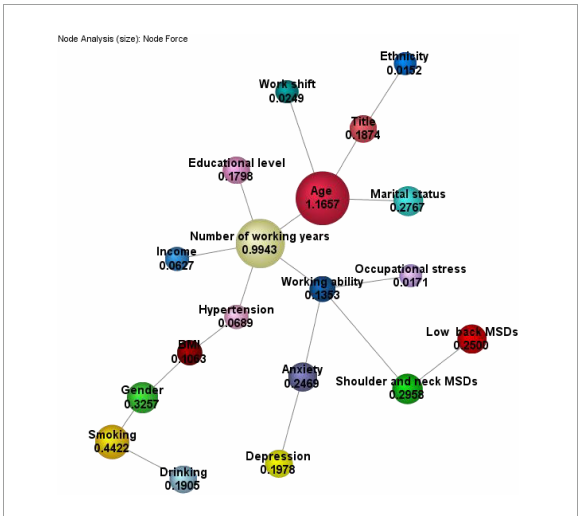
FIGURE1 Node force analysis of unsupervised Bayesian